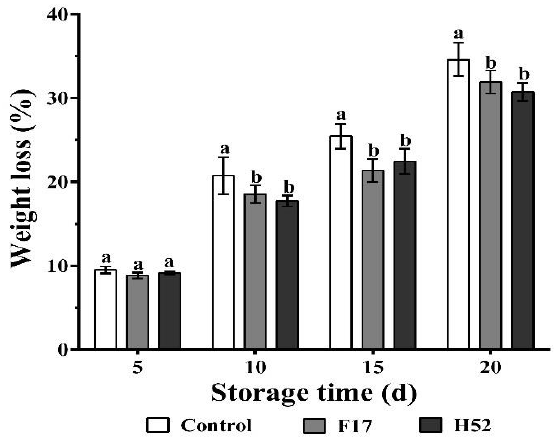
Figure 1. Changes in weight loss with different treatments during storage at 25 °C. Different lowercase letters at the same storage time indicate a significant difference ( p < 0.05).